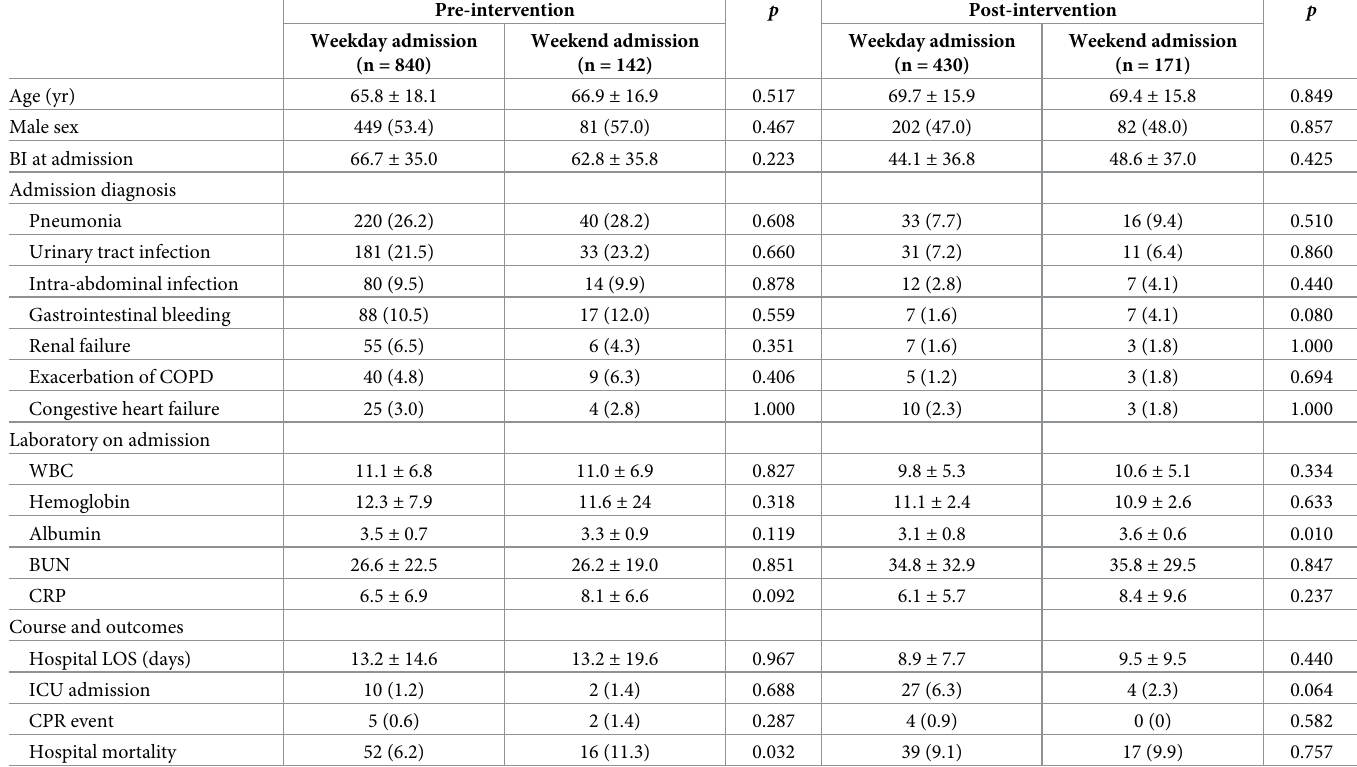
Table 2. Characteristics and outcomes of the pre- and post-intervention cohort in caring for weekday and weekend